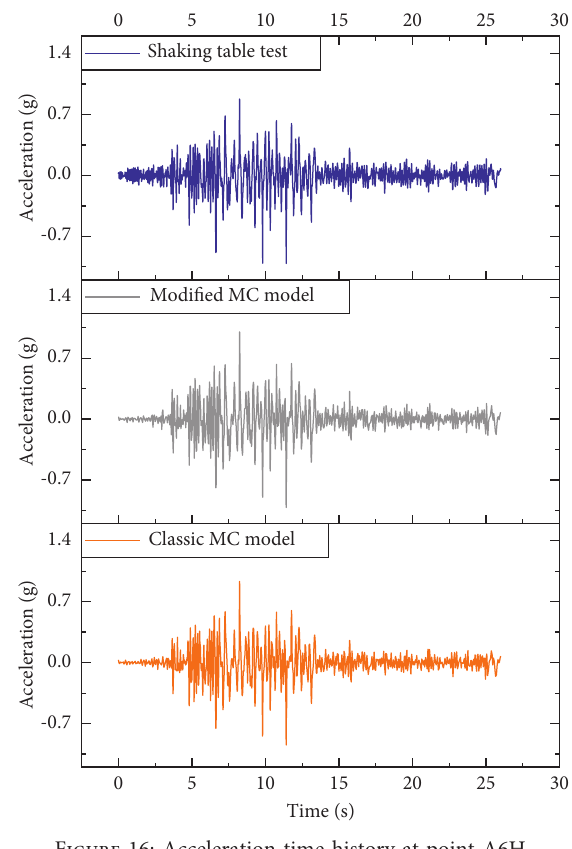
Figure 14: Acceleration time history at point A5H.